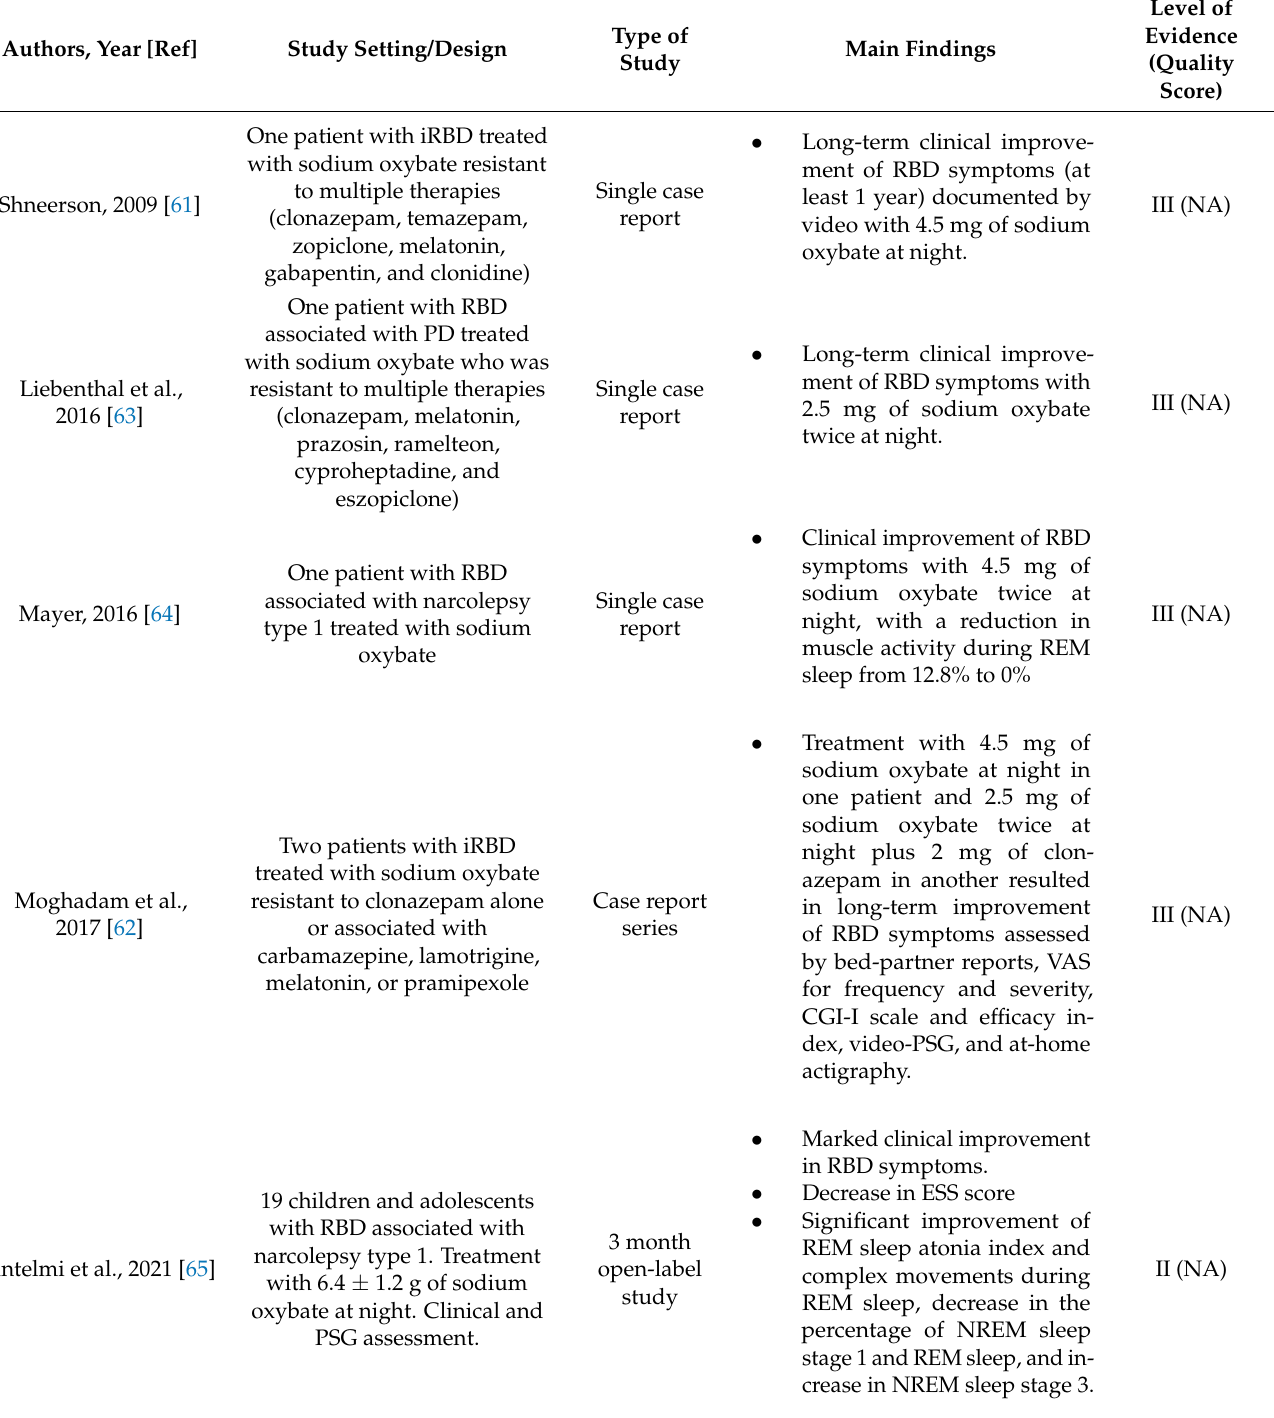
Table 5. Studies describing effects of sodium oxybate in patients with